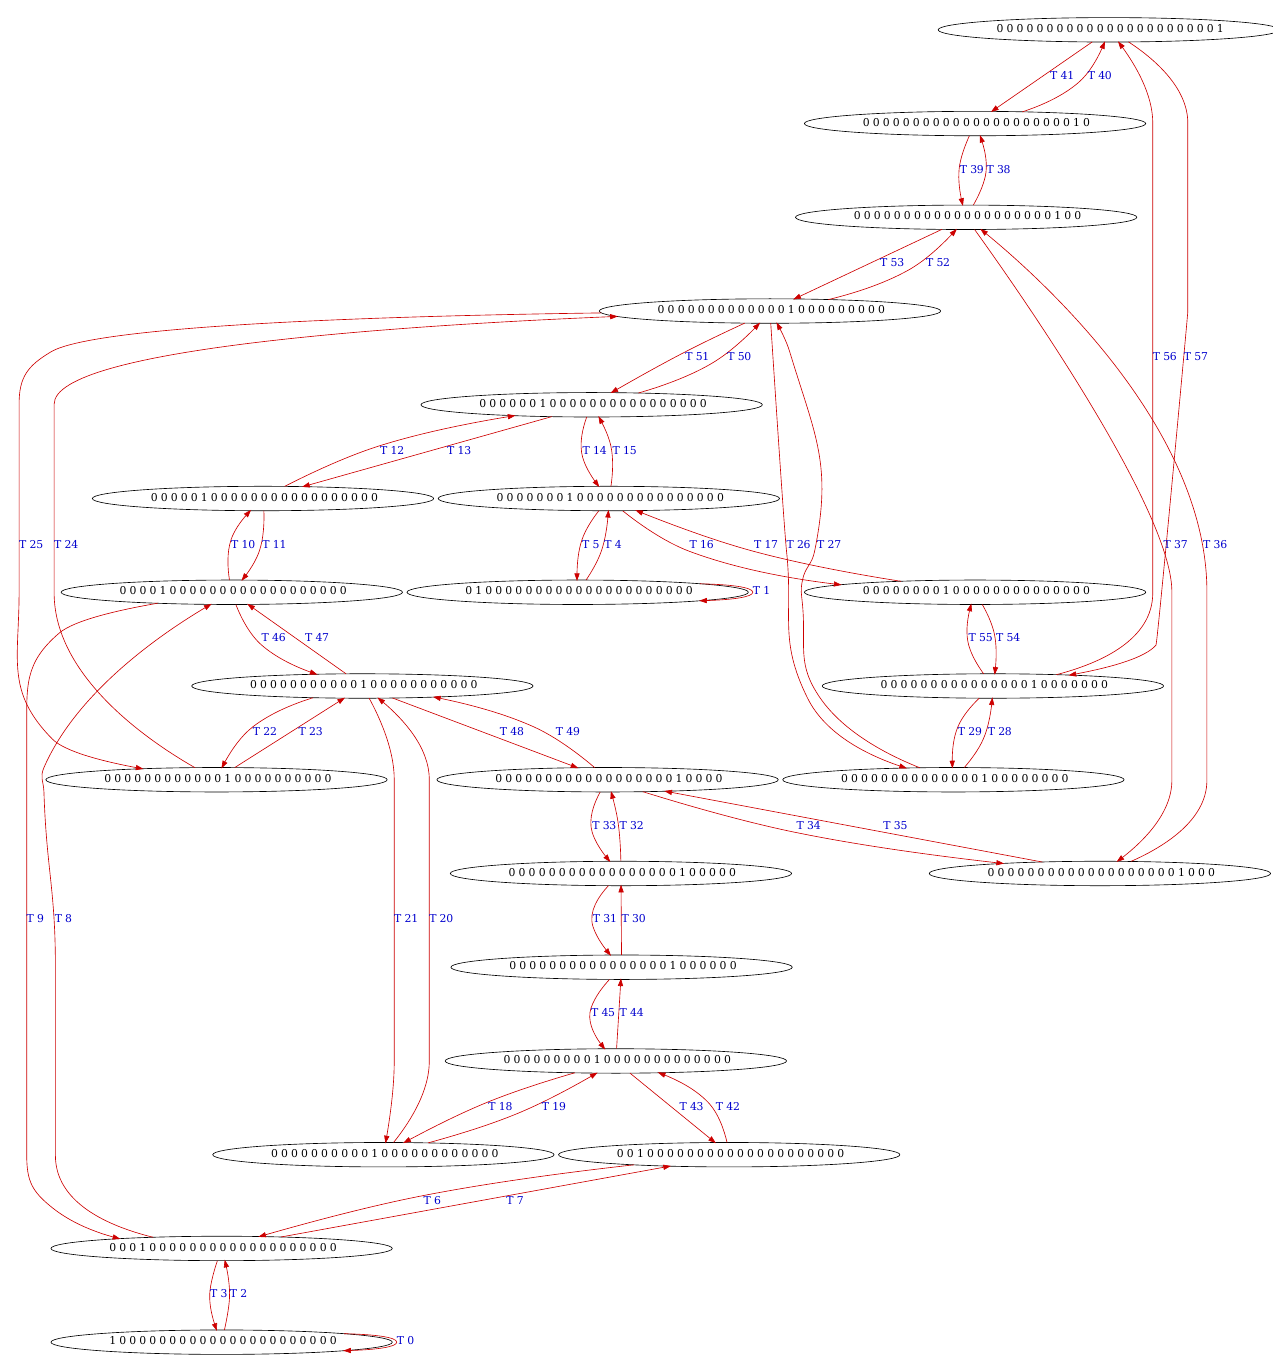
Figure 4. Example reachability graph for a single AGV for the CPN model shown in Figure 3. As depicted in Algorithm 1, a list of possible firings is initially instantiated, where an empty θ firing vector (no fireable transition) is inserted. Then, for each fireable and nonblocked transition, a copy of it is performed and the correspondent transition activated for all elements in the duplicated list. Lastly, all firing possibilities contained in the copyList are appended to the original list. Moreover, the assumption that only a transition from a couple that connects two places can be activated is made, which means that only a single AGV can go through a passage each time (unidirectional road). Given the example above depicted in Figure 3, T 6 and T 7 cannot simultaneously be